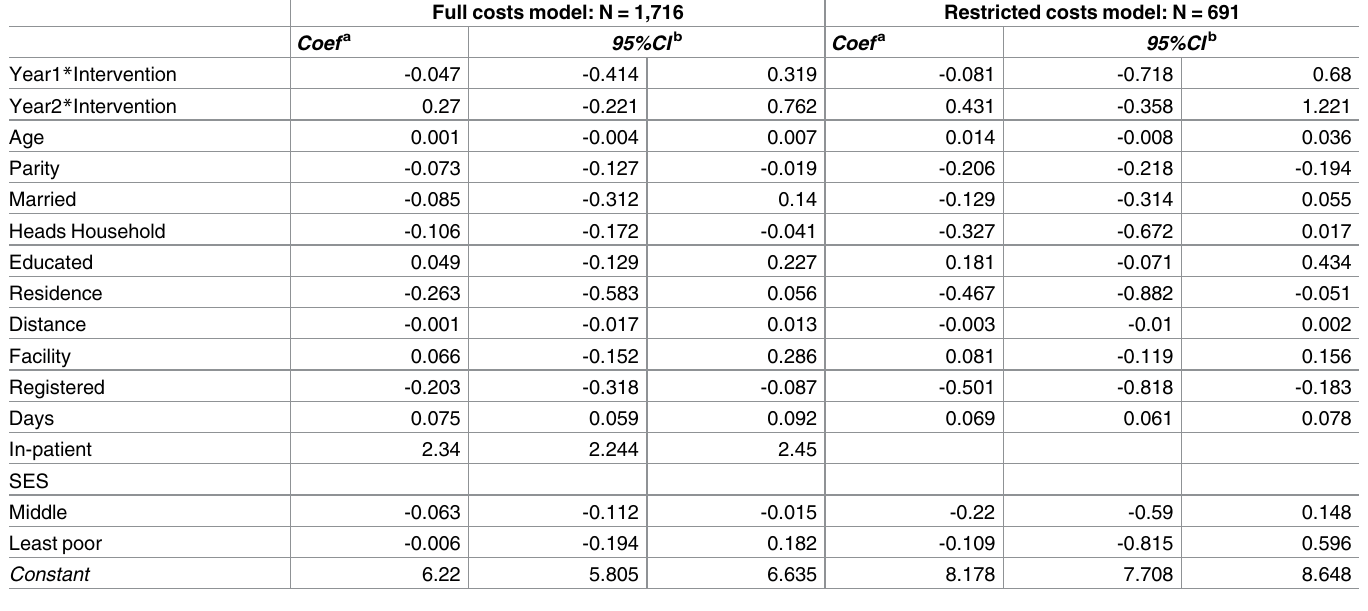
Table 5. Effects of RBF on household costs,adjusted for covariates.